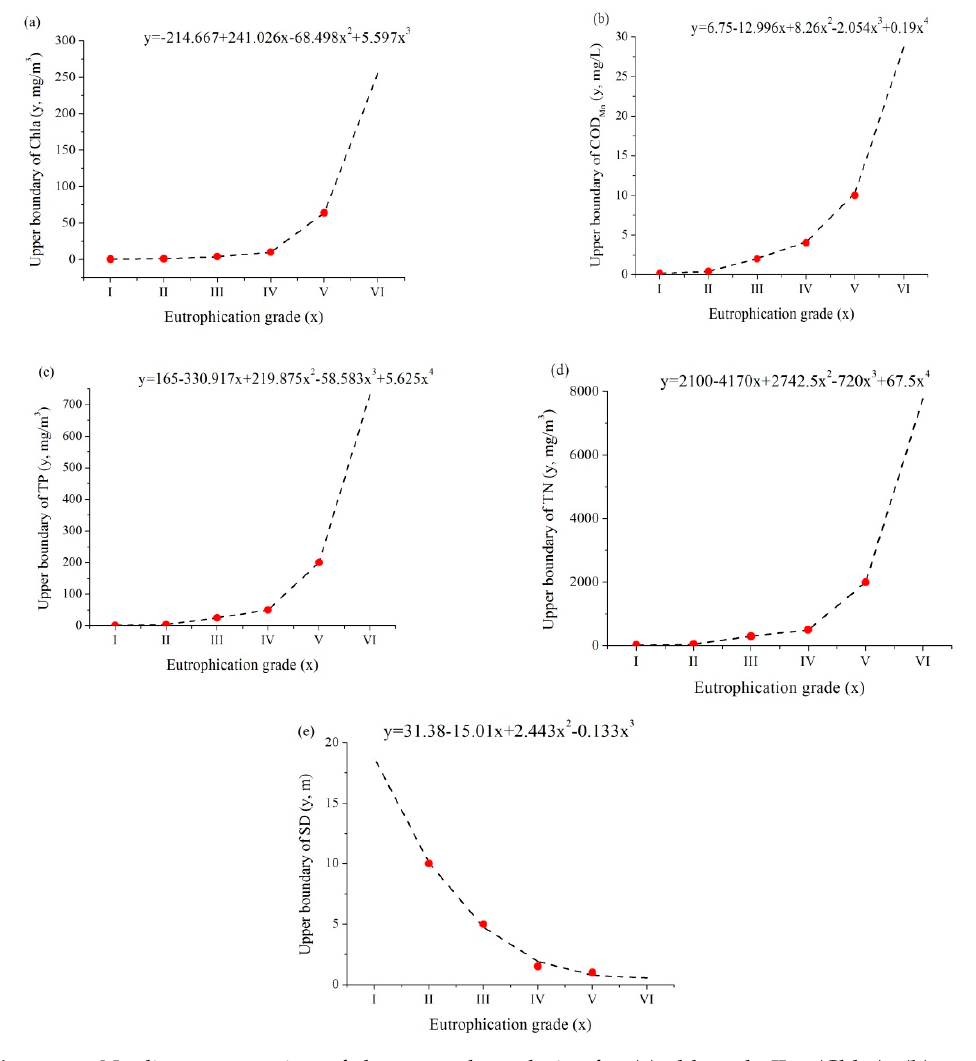
Figure 1. Nonlinear regression of the upper boundaries for ( a ) chlorophyII-a (Chl-a), ( b ) total phosphorus (TP), ( c ) total nitrogen (TN), ( d ) chemical oxygen demand (COD Mn ), and ( e ) clarity (SD).